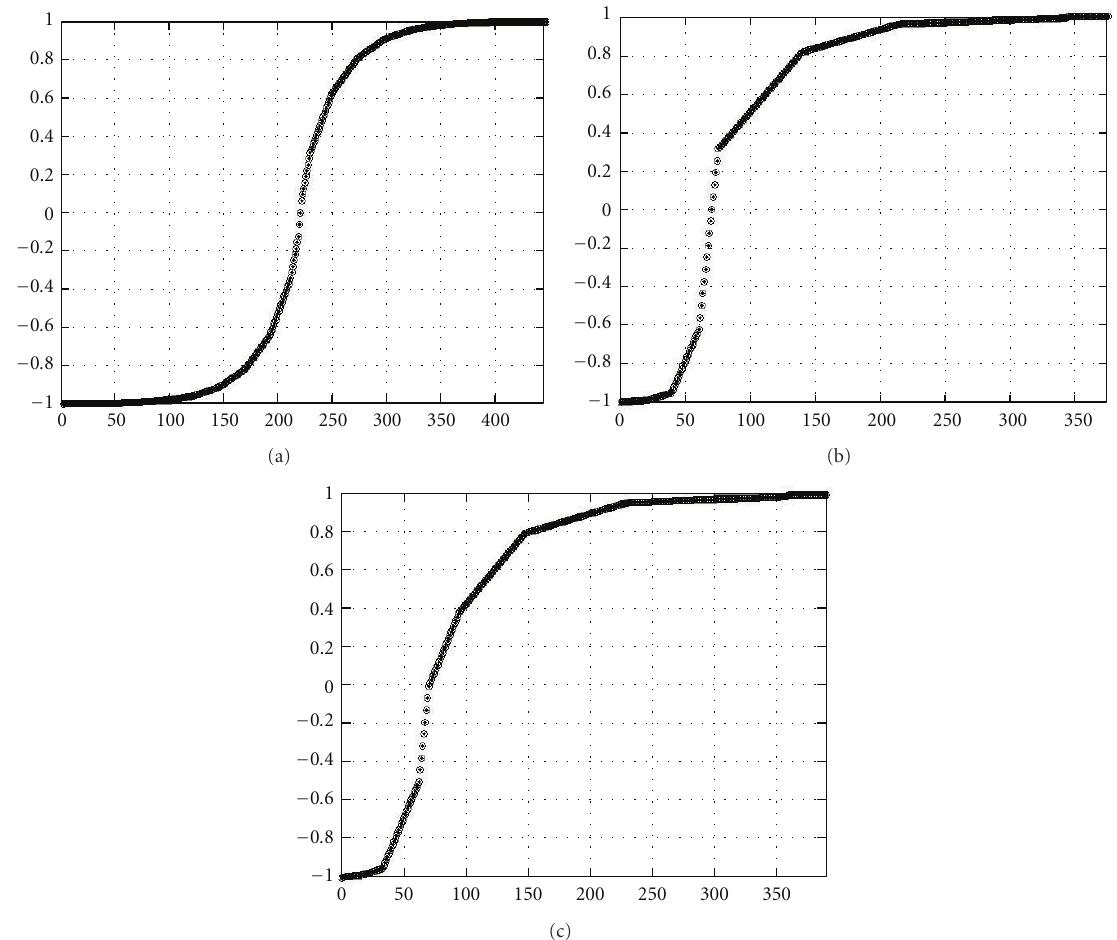
Figure 7: The abscissa values x n